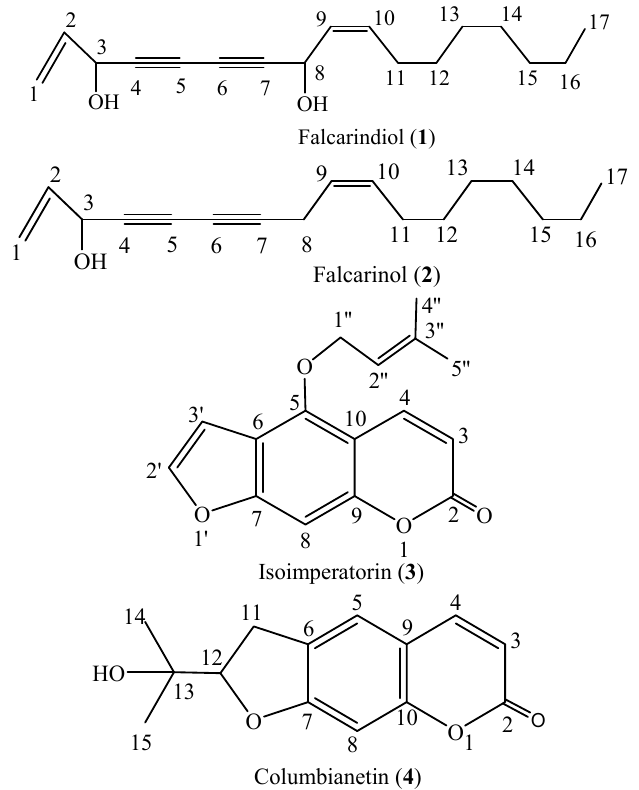
Figure 1. Constituent compounds isolated from the ethanol extract of Notopterygium incisum rhizomes.